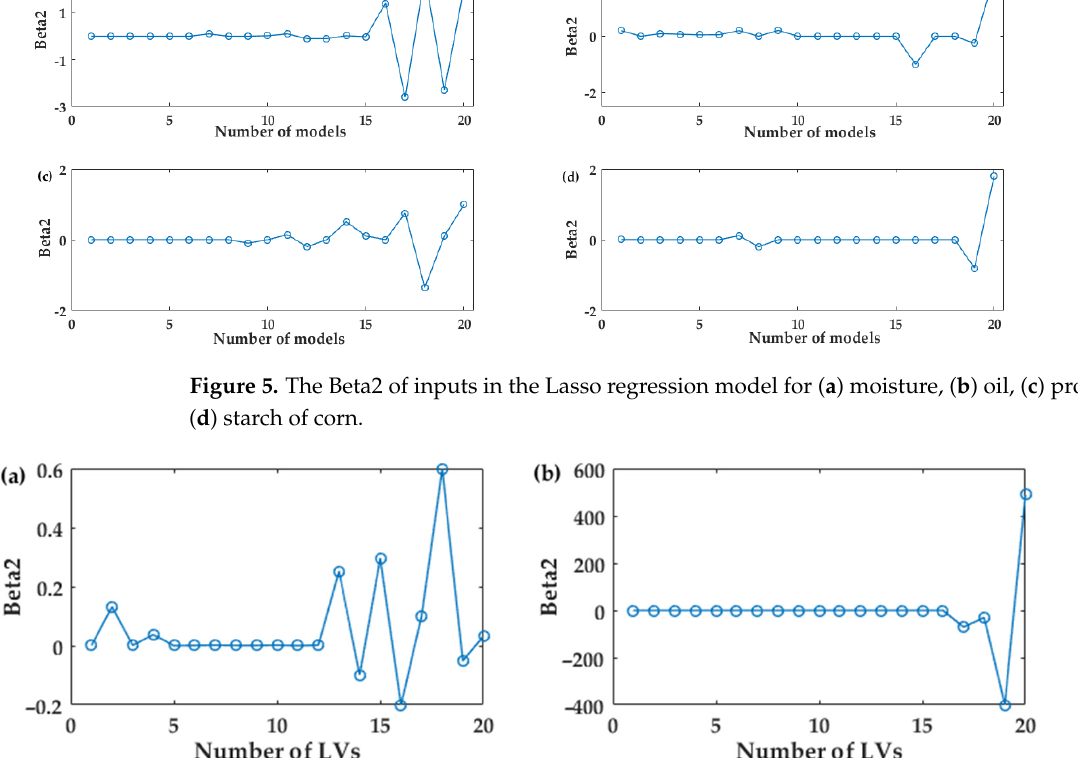
Figure 6. The Beta2 of inputs in the Lasso regression model for ( a ) SSC of apple and ( b ) moisture of marzipan. SSC: soluble solids contents.